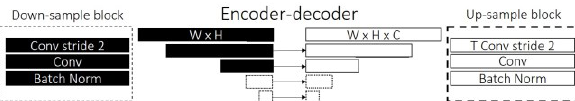
Figure 3. Encoder-decoder with mirrored architecture. Arrows depicted in the figure represent concatenation connections. The depth of the model changes according to the number of blocks. For each down-sample block, an up-sample block is added. W, H, C are the width, height, and the number of output channel respectively.